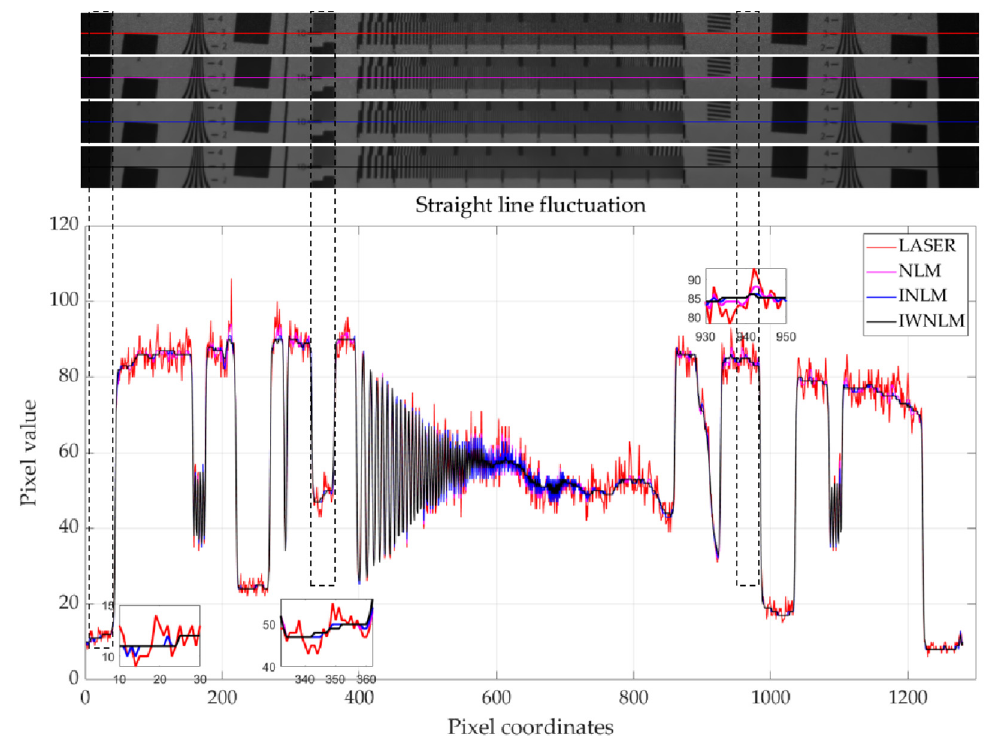
Figure 13. Linear fluctuations of laser image and filtered image.